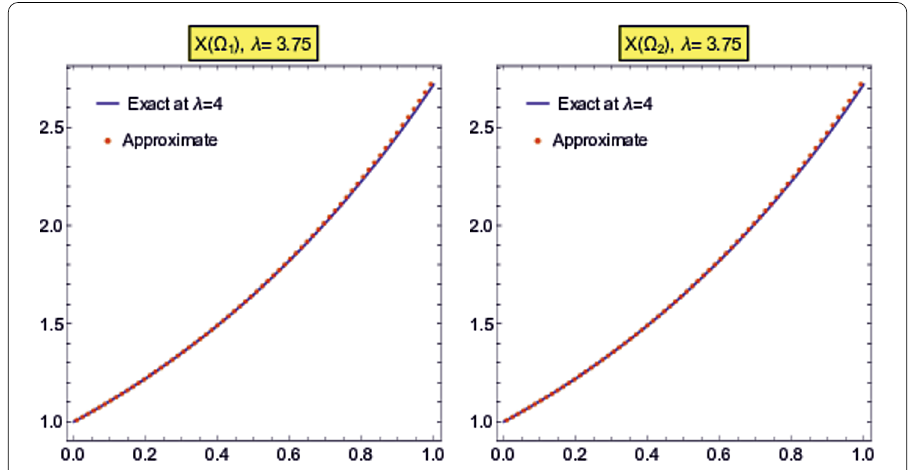
Figure 5 Comparison of the exact and approximate solutions of Example 4.1 for m = 3 and λ = 3.75